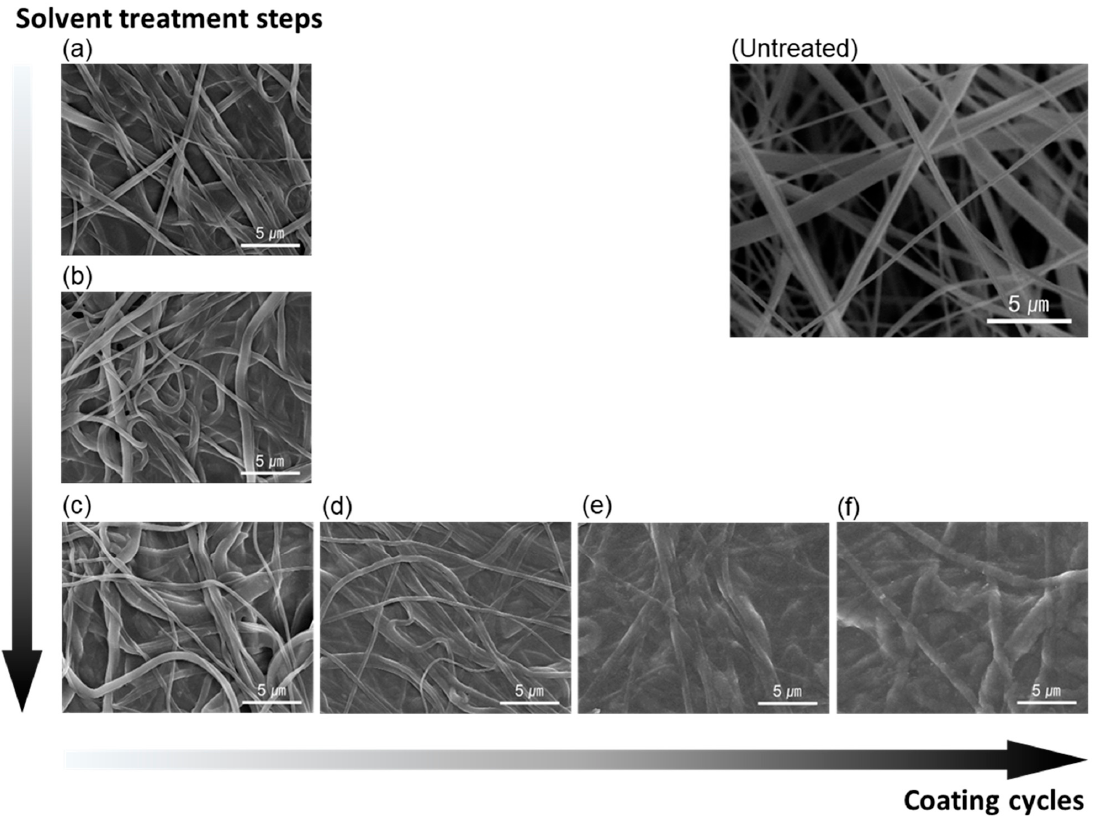
Figure 7. FE-SEM images of the untreated and treated samples ( × 5000); ( a ) P1, ( b ) PD1, ( c ) PD1-D, ( d ) PD2-D, ( e ) PD3-D, ( f ) PD4-D.